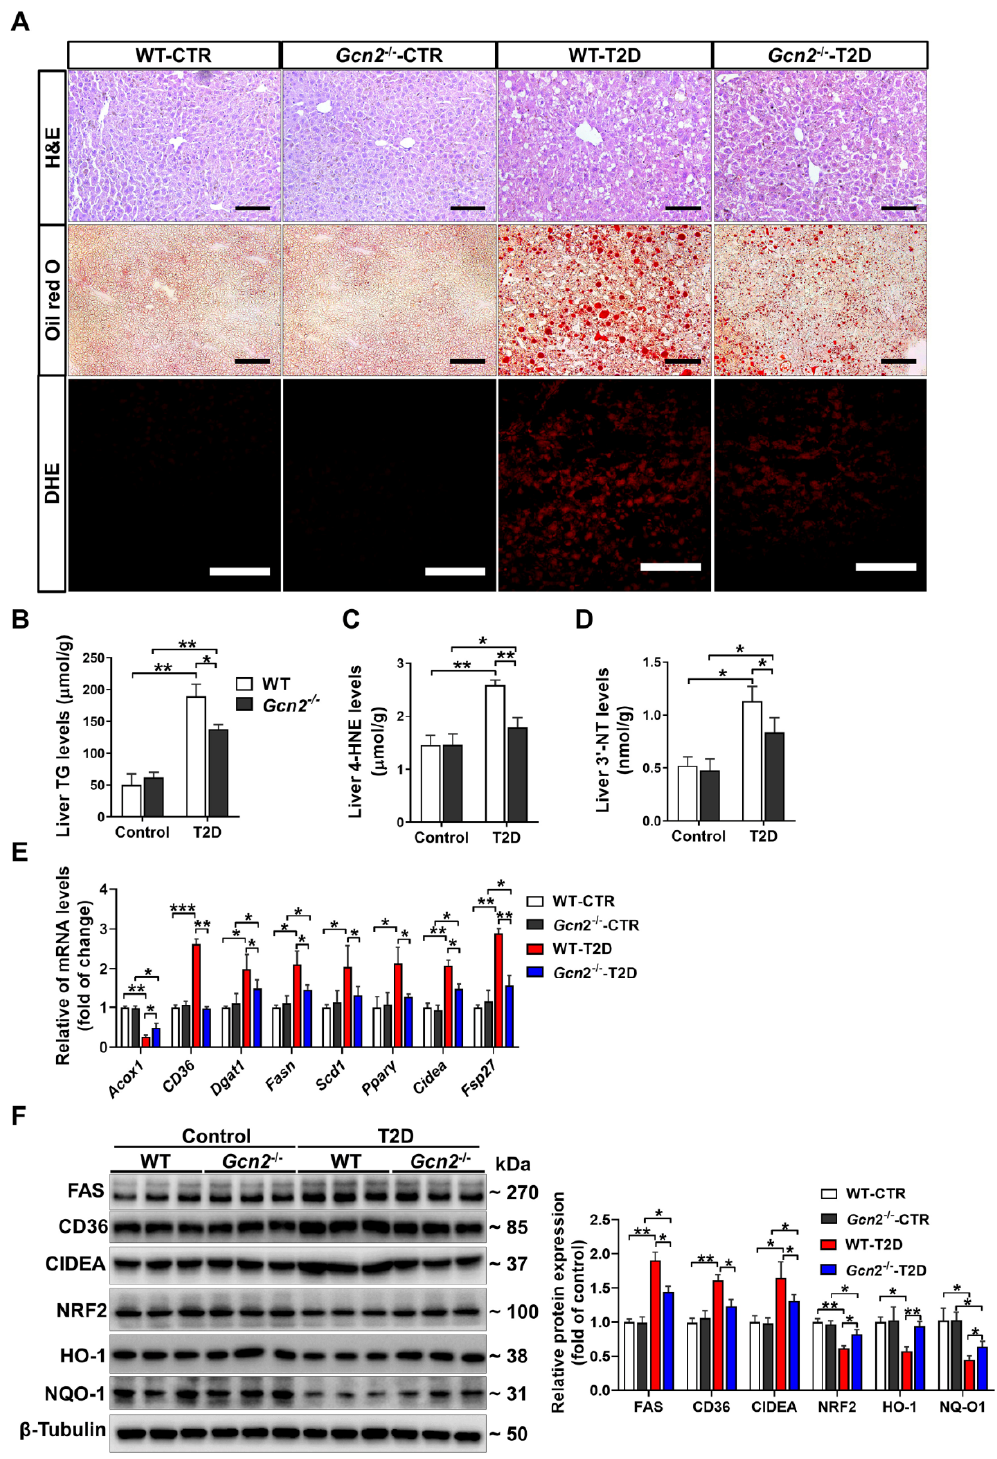
Figure 2. GCN2 deficiency ameliorates hepatic steatosis and oxidative stress in T2D mice. ( A ) Representative liver sections were stained with hematoxylin and eosin (H&E), oil red O, and dihydroethidium (DHE). Scale bar = 100 μ m. Liver triglyceride (TG) ( B ), 4-hydroxynonenal (4-HNE) ( C ), and 3 ′ -nitrotyrosine (3 ′ -NT) ( D ) levels were measured. ( E ) The mRNA levels of genes involved in lipid metabolism were measured by qPCR. ( F ) Liver lysates from control and T2D mice were examined by Western blot. N = 5 ( B – E ) or 3 ( F ); values are means ± SD; * indicates p < 0.05; ** indicates p < 0.01; *** indicates p <